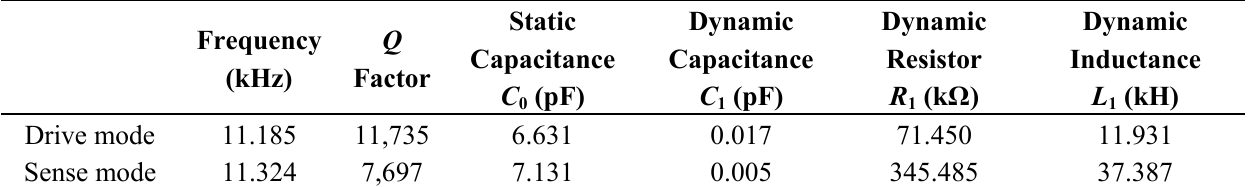
Table 3. Values of the drive mode and sense mode of the